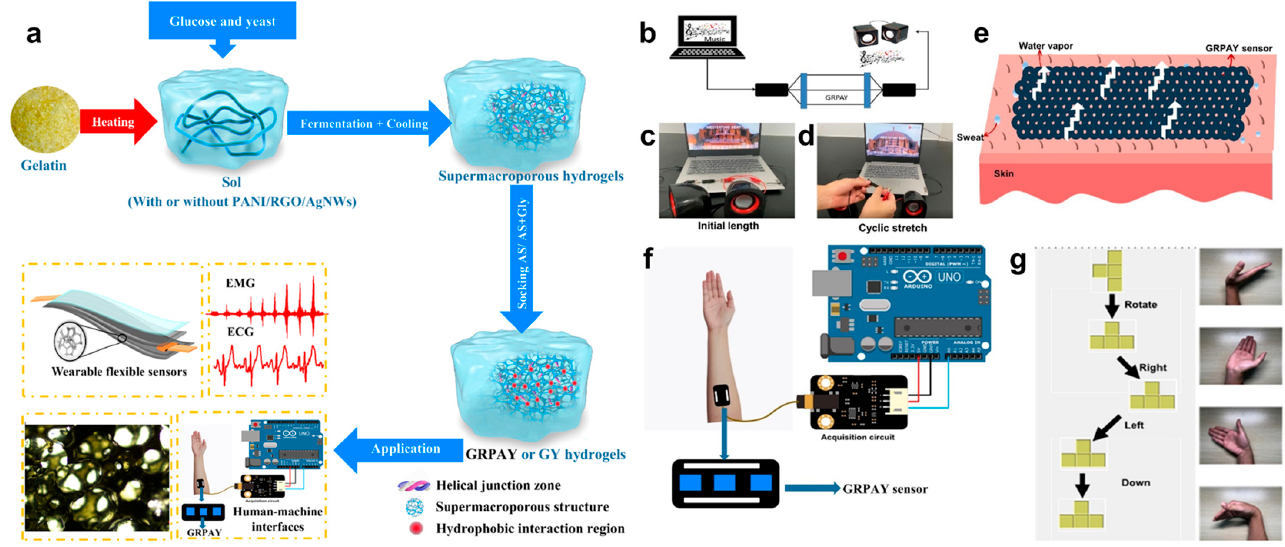
Figure 7. Preparation process and applications of GRPAY/GY hydrogels. ( a ) Fabrication procedure and corresponding applications of GRPAY/GY hydrogels. ( b – d ) Schematic illustration of GRPAY hydrogels cable for signal transmission, and photographs showing normal working state of GRPAY hydrogels cable under cyclic stretching. ( e ) Schematic diagram presenting breathability of the GRPAY sensor on skin. ( f ) HMI realized by GRPAY sensor. ( g ) Photographs illustrating playing Tetris game controlled by signals of 4 different gestures acquired from GRPAY sensor [135].